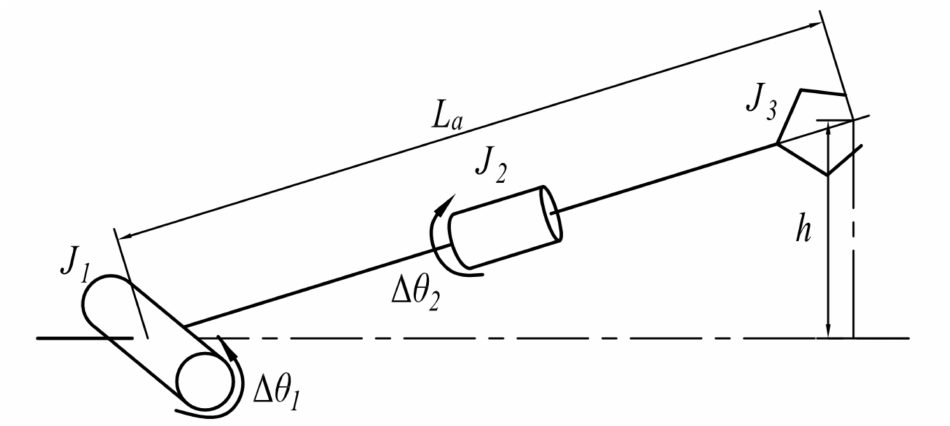
Figure 24. The illustration of the manipulator motion parameters. In the figure, J 1 represents the shoulder joint; J 2 represents the wrist joint; and J 3 represents scissors. ∆ θ 1 and ∆ θ 2 represents the rotation angle of the shoulder and wrist joint; h represents the current height of the scissors; L a represents the length of the